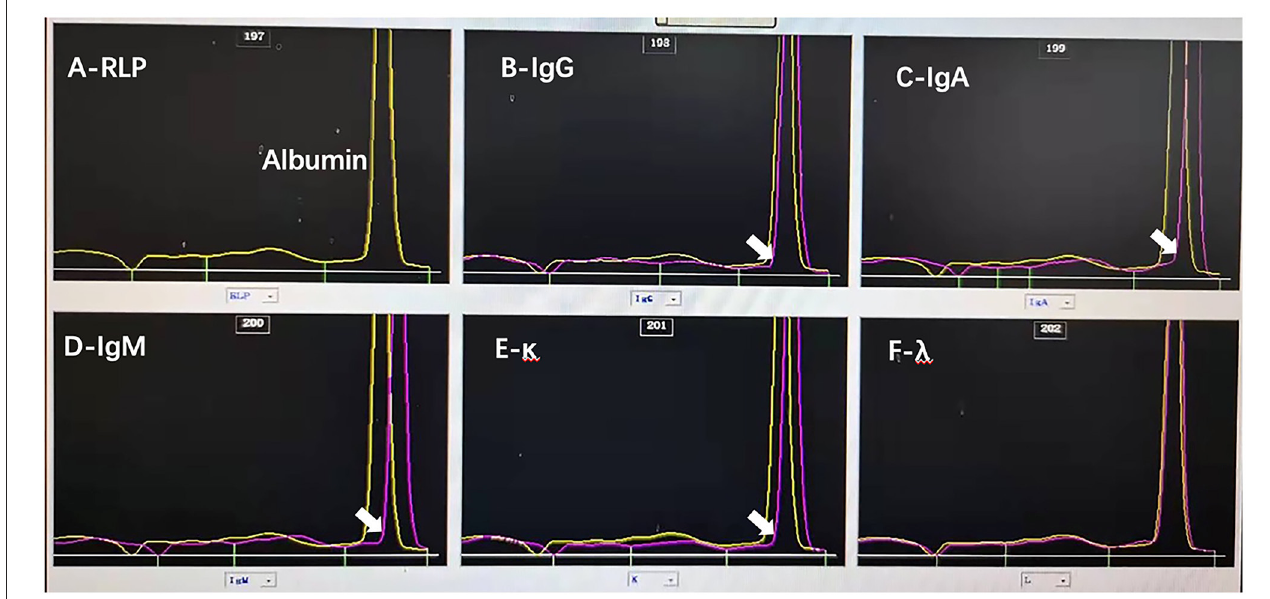
FIGURE3 The results of capillary electrophoresis directing analysis of serum by capillary electrophoresis with detection at 200nm. Polyclonal IgG κ and IgA κ proteins are identified in the serum of the patient by using fully automated capillary electrophoresis. The ELP pattern of (A) (yellow line) is the original serum line which is the electrophoresis result of the original sample. (B) The serum contains an IgG polyclonal protein. (C) The serum contains an IgA polyclonal protein. (D) The serum does not contain an IgM protein. (E) The serum contains a kappa chain, and (F) the serum does not contain a light chain.